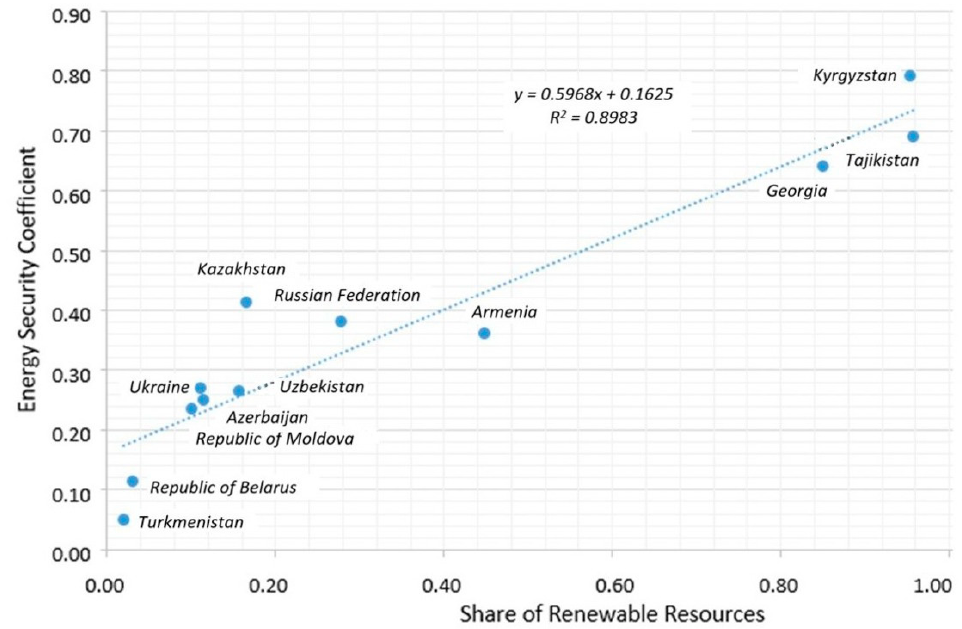
Figure 5. The relation between the share of RES and energy security in EECCA according to PES in 2019. Source: compiled by the authors.